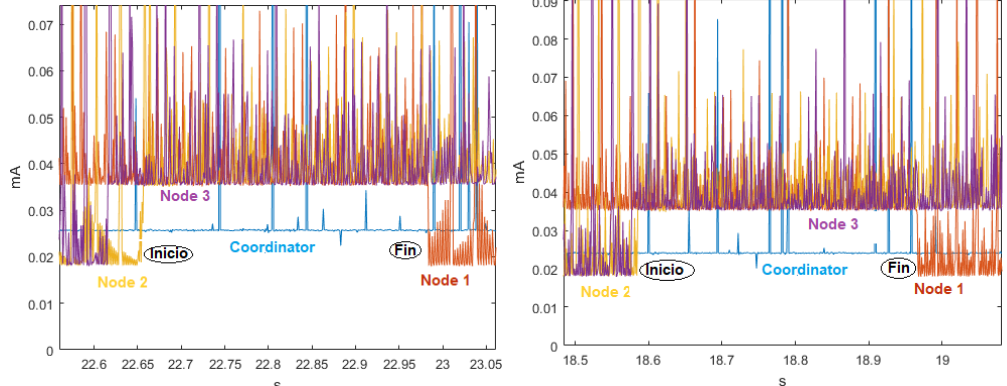
Figure 9. Complete time signals for ZigBee network at 9600 bauds in two example realizations: ( Left ) Realization 4; and ( Right ) Realization